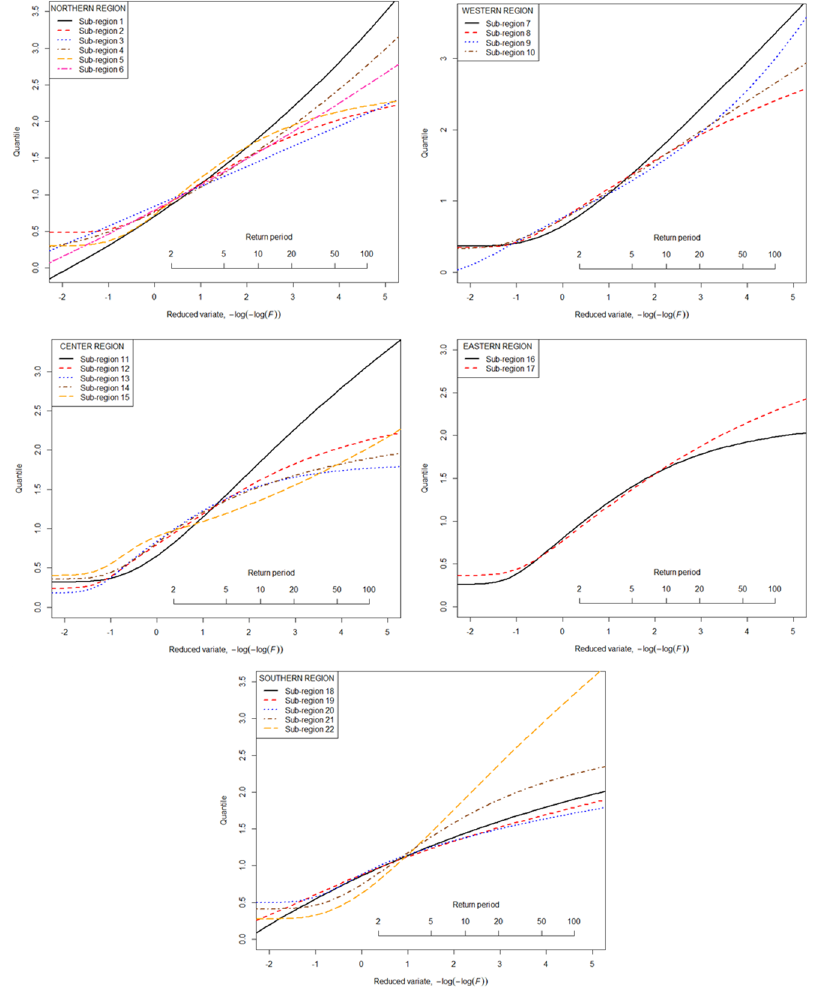
Figure 7. Regional growth curves of 22 homogeneous regions in Taiwan.